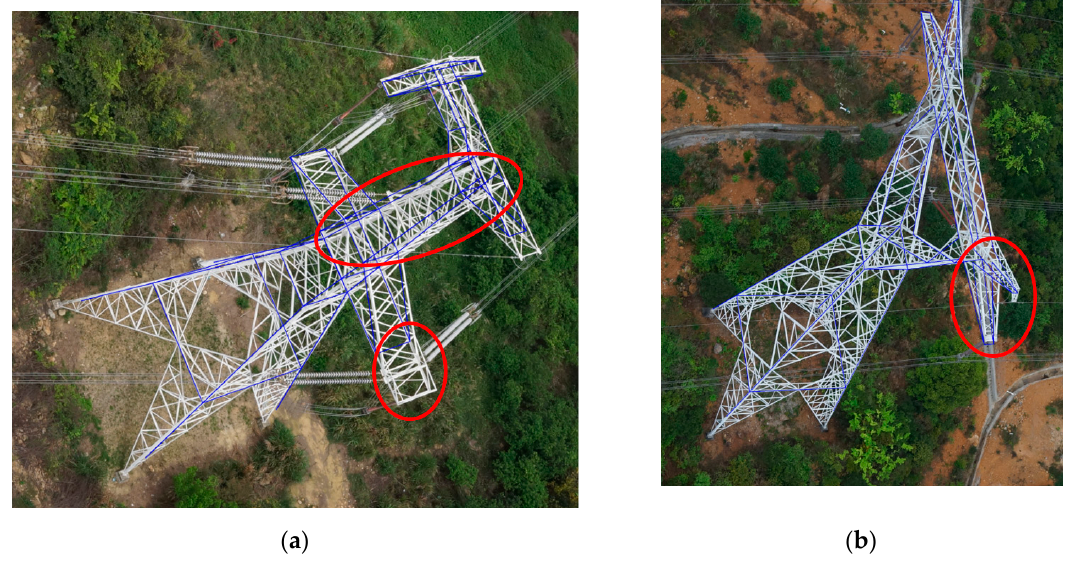
Figure 14. Examples of reconstruction errors ( a , b